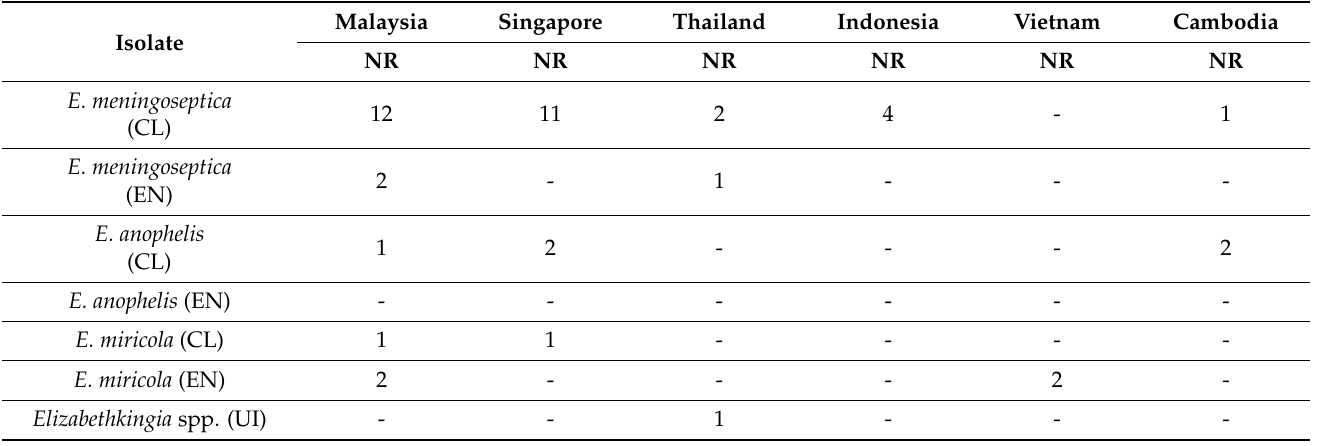
Table 2. Elizabethkingia spp. isolated from various Southeastern Asian countries based on the published reports until March